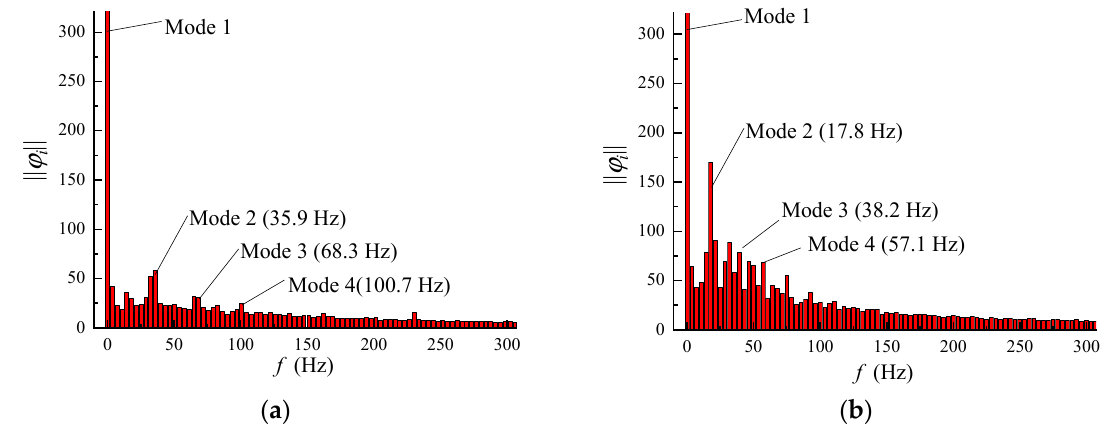
Figure 11. Comparison of the energy spectrum of the dynamic modes with free surface and without free surface. ( a ) Near free surface ( h = 0.25 C ); ( b ) No free surface.